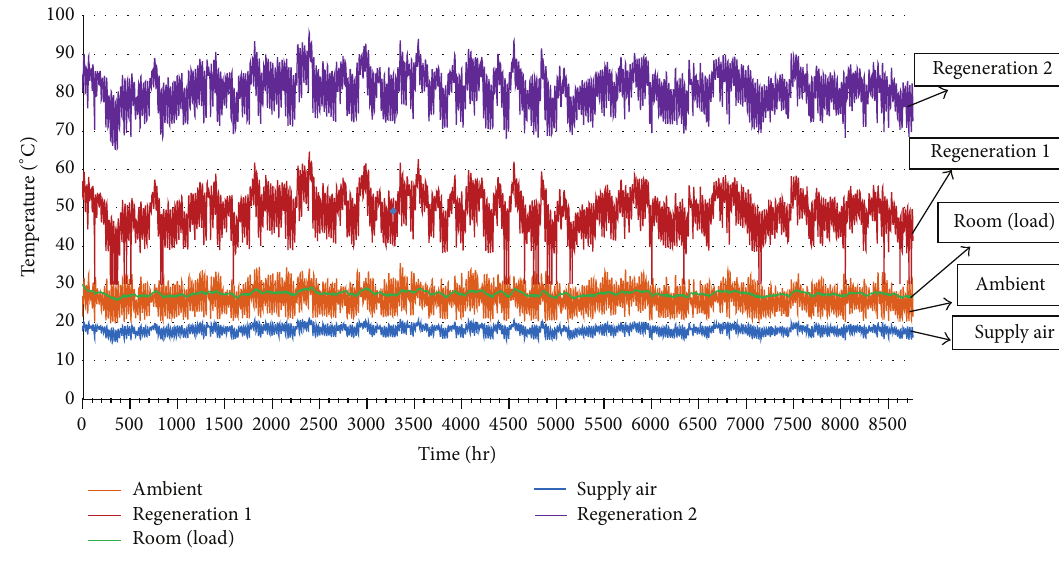
Figure 14: Temperatures ( ∘ C) of different components versus time (hr) in two-stage recirculation desiccant cooling system.